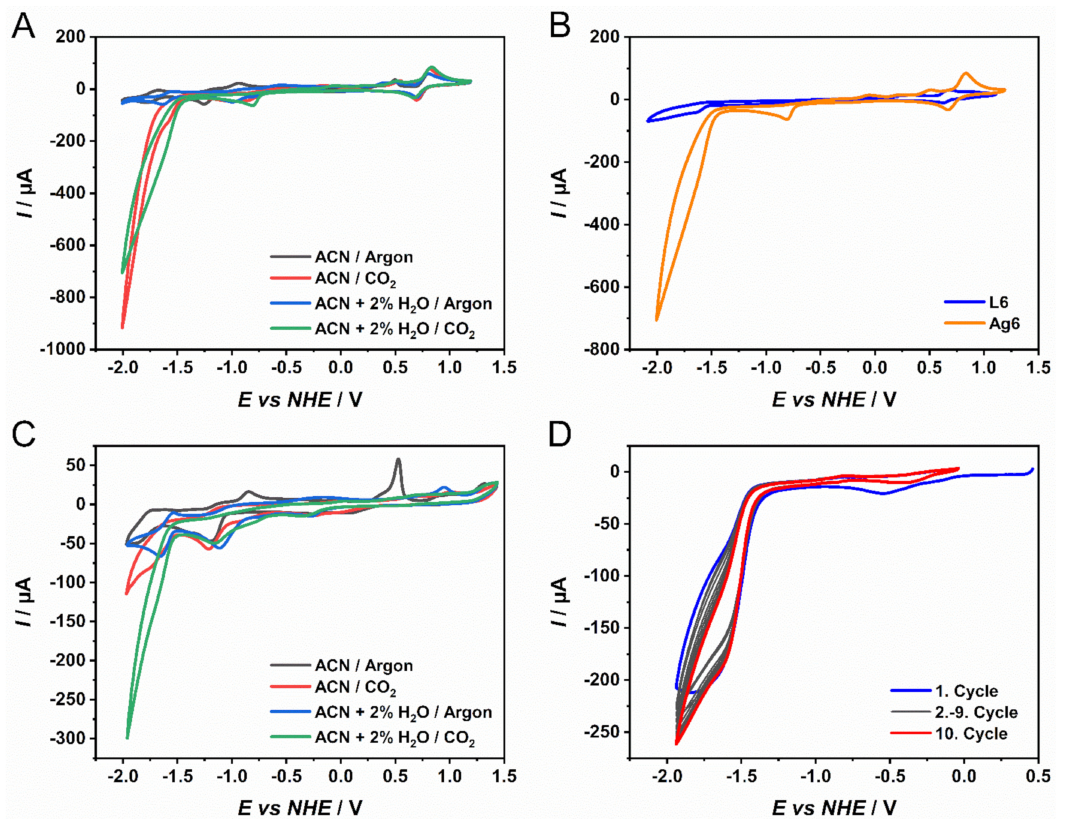
Figure 4. Homogeneous electrocatalysis of BIAN ligand L6 and Ag(I) bis-BIAN complexes Ag4 and Ag6 . ( A ) Comparison of CVs of Ag6 in ACN under argon (black), CO 2 (red), in ACN with 2% H 2 O under argon (blue) and CO 2 (green) at 100 mV s − 1 scan rate. ( B ) CV response overlay of L6 (blue) and Ag6 (orange) in ACN with 2% H 2 O under CO 2 . ( C ) Comparison of CVs of Ag4 in ACN under argon (black), CO 2 (red), in ACN with 2% H 2 O under argon (blue) and CO 2 (green) at 100 mV s − 1 scan rate. ( D ) Stability test of Ag6 in ACN with 20% H 2 O under CO 2 scanning ten purely cathodic cycles not portending a decrease in catalytic